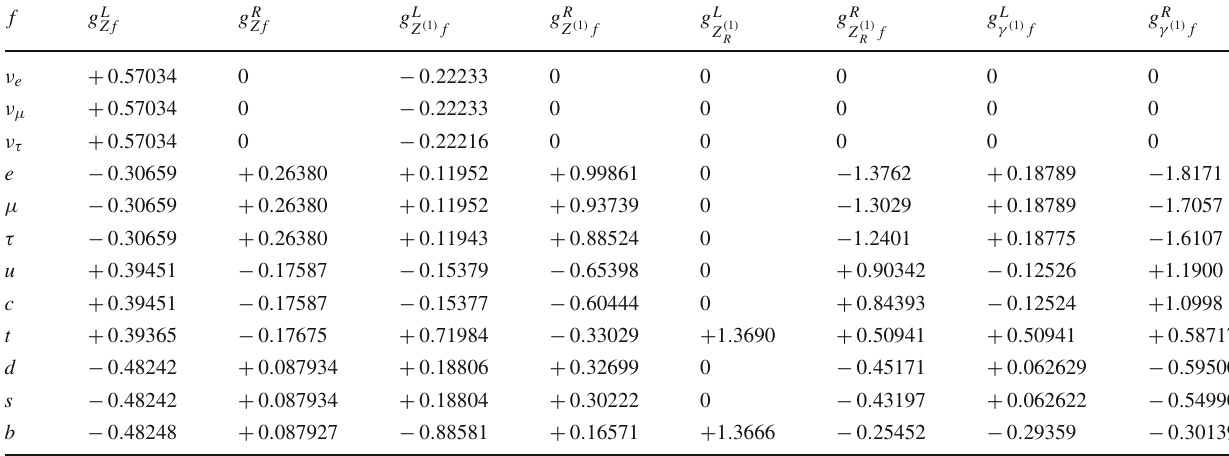
Table 5 Z (cid:3) couplings of fermions for θ H = 0 . 08, c l , c q > 0. The same unit as in Table 3